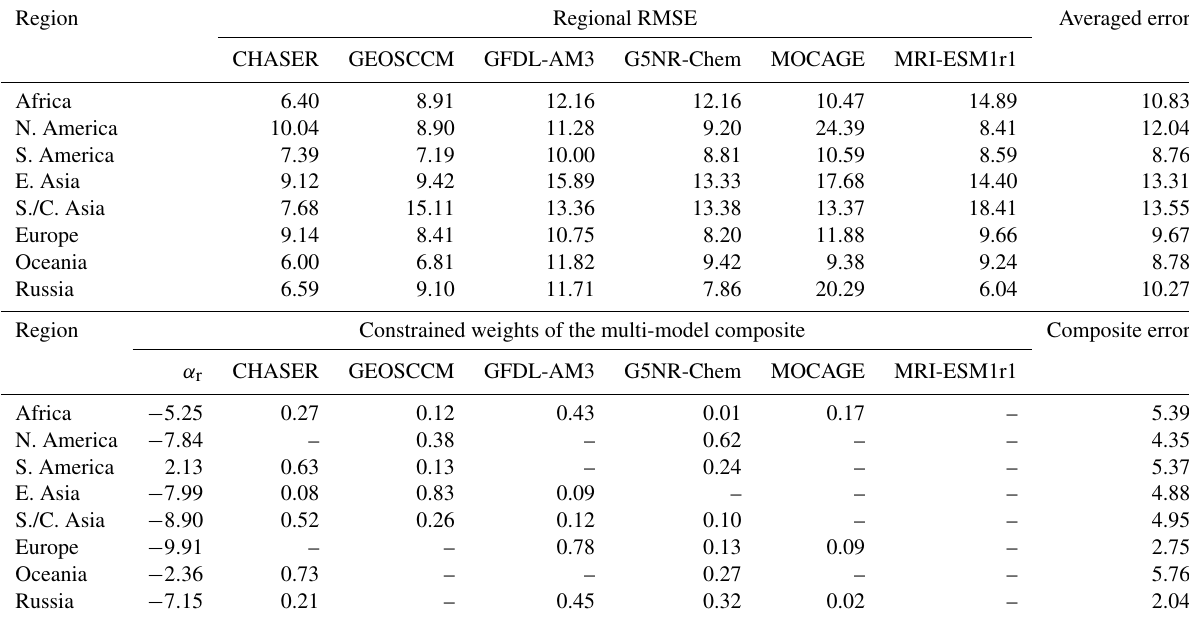
Table 2. RMSEs (averaged errors in a given region) between spatially interpolated observations and each model, along with regionally optimized weights { β rk : for k th model in region r } (zero weights are not displayed). Last column shows the RMSEs from equal weighted averages or constrained weights from the multi-model composite. All the numbers are reported in units of ppb (i.e., parts per billion by volume).